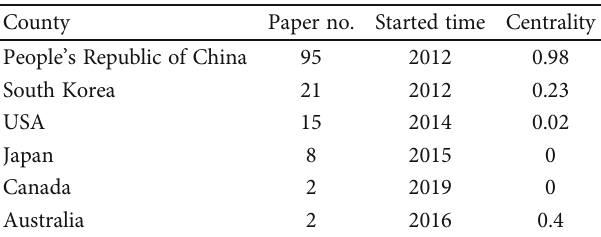
Figure 3: Time-zone diagrams of di ff erent countries participating in the PI-based material for separator application. Table 1: The number, started time, and centrality of published papers in di ff erent